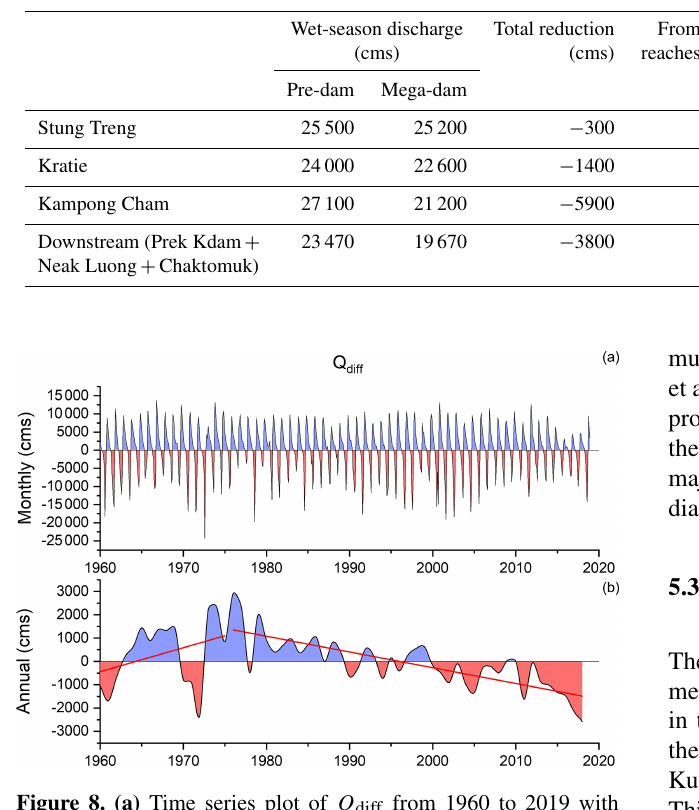
Table 2. Percentage contribution of influences upstream of Stung Treng to the reduction of discharge at the various stations in the Cambodian floodplains.